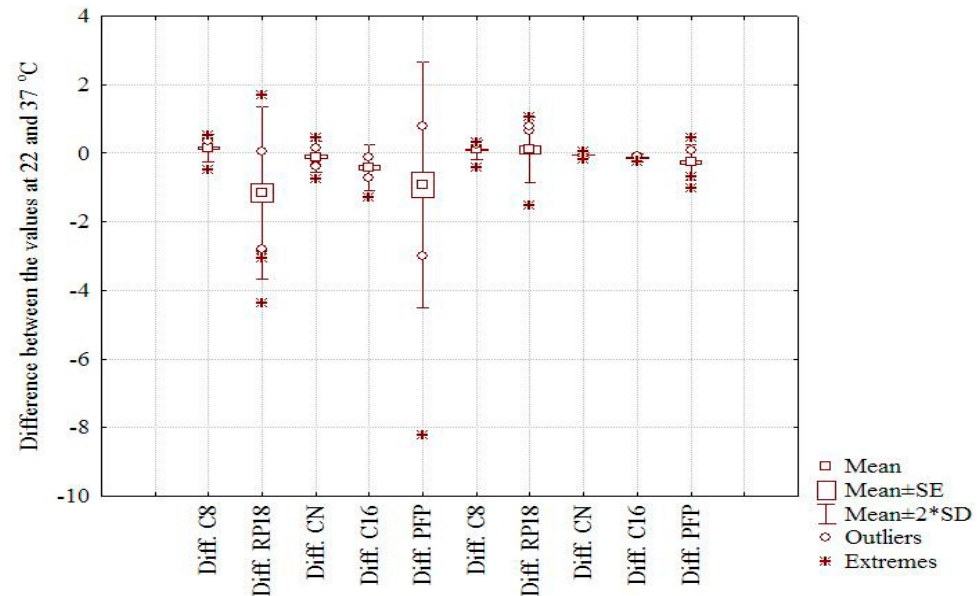
Figure 2. Box and whiskers corresponding to logk w values, (the first five boxes, from left to right) and m logk values, respectively (the last five boxes).